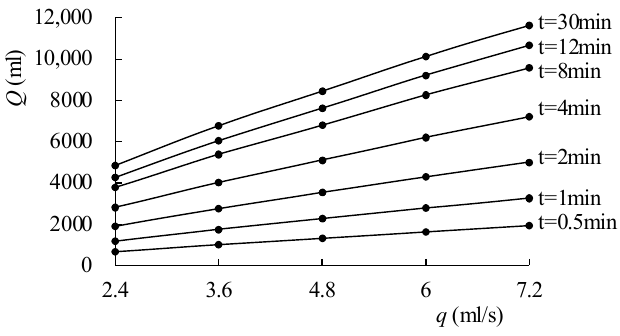
Figure 6. The ESC ( Q s )—recharge intensity ( q ) relationship curves.